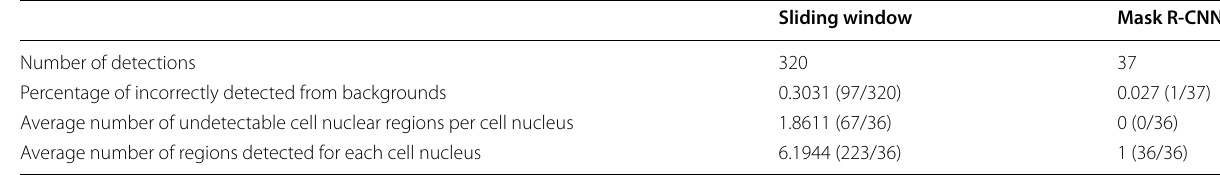
Table 2 Comparison of the results of the sliding window method (SWM) and mask region-based convolutional neural network (Mask- RCNN)